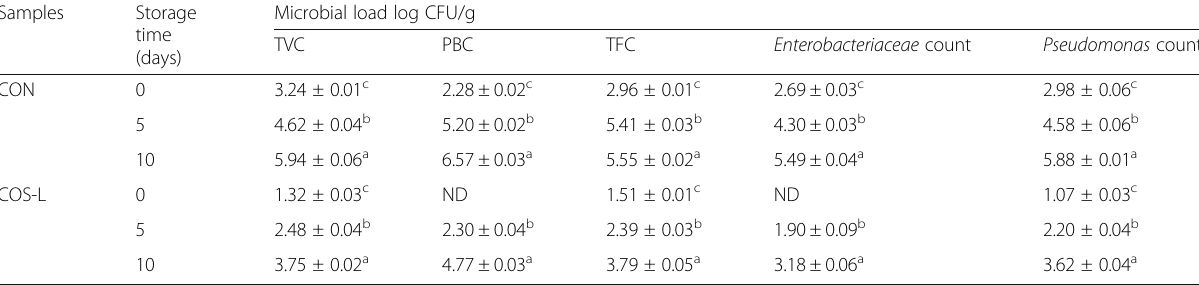
Table 3 Microbial counts of sardine surimi gel added without and with 1% COS-L from squid pen